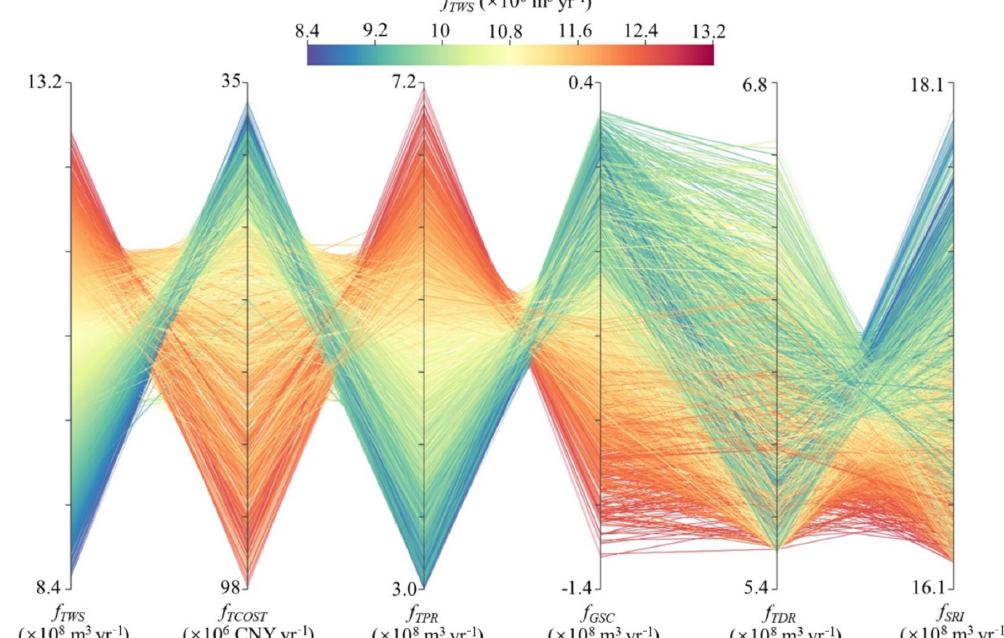
Figure 7. The objective values ( y axis) are plotted over management objectives f TWS , f TCOST , f GSC , f SRI , total pumping rate f TPR , and total surface water diversion rate f TDR ( x axis). f TWS is represented in color. The preferred direction for each index is